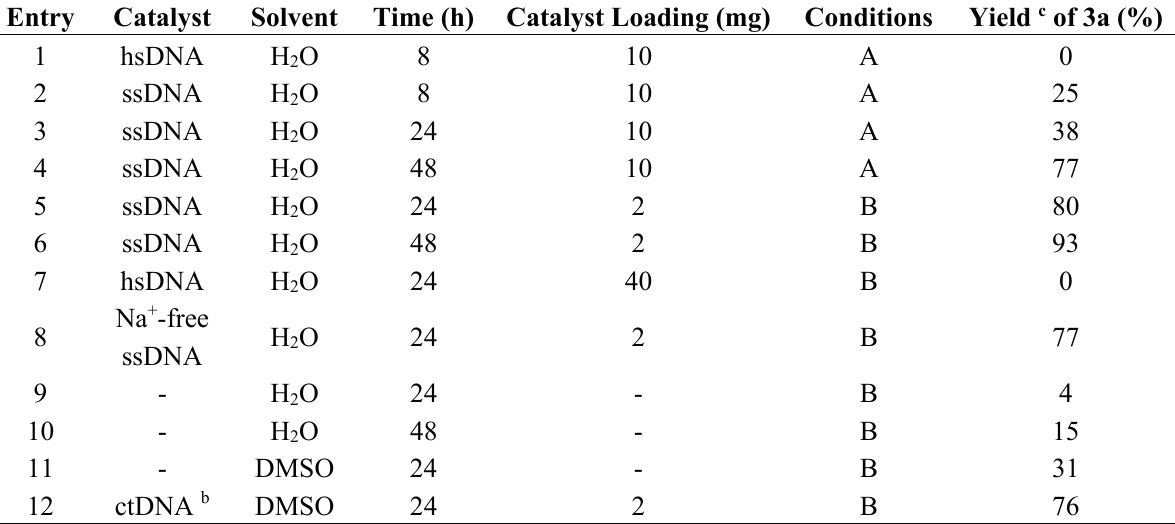
Table 4. Initial screening of reaction conditions.